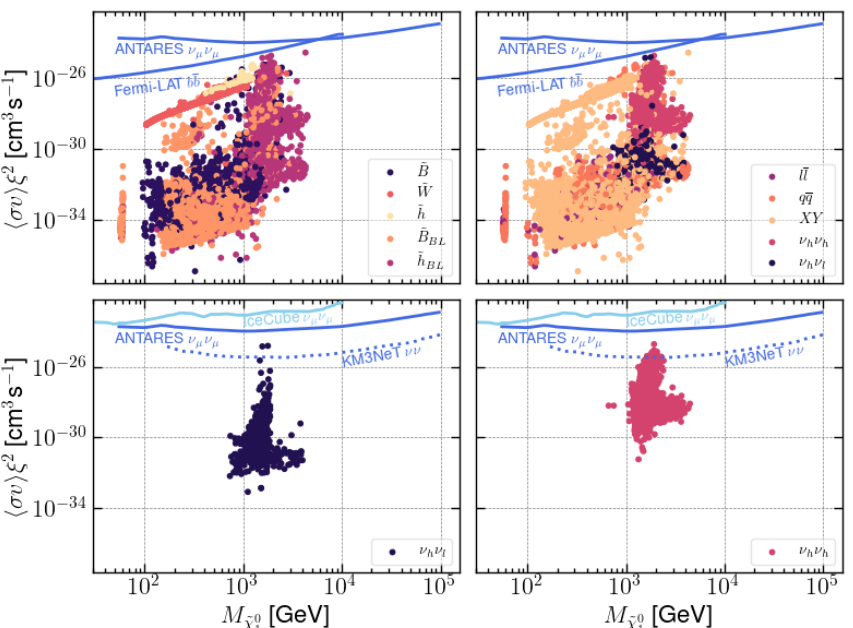
Figure 5: The DM velocity-weighted annihilation cross section (scaled with the square of their relic density divided by 0.12 and their branching ratio) in cm 3 s − 1 as a function of the mass of the LSP (in GeV). The upper panels show the domi- nant component (upper-left) and dominant annihilation channel (upper-right). For the dominant annihilation channel, we use qq to indicate any combination of quarks produced in a DM annihilation process, ll any combination of leptons, X Y any com- ν bination of two bosons such that charge is conserved, ν any combination of two h h ν heavy neutrinos, and ν any combination of a heavy neutrino and light neutrino. h l ν The bottom panels isolate explicitly the LSPs that annihilate mostly into ν (lower- h h ν right) and ν (lower-left). The Fermi-LAT bb gamma-ray limit and ANTARES ν µ ν µ h l neutrino limits are shown in the upper plots. The bottom plots show the IceCube and ANTARES ν µ ν µ neutrino limits. Furthermore, the projected KM3NeT νν limits are shown in the bottom plots. The cuts of table 2 have been applied to all shown points, and in addition we require Ω h 2 <